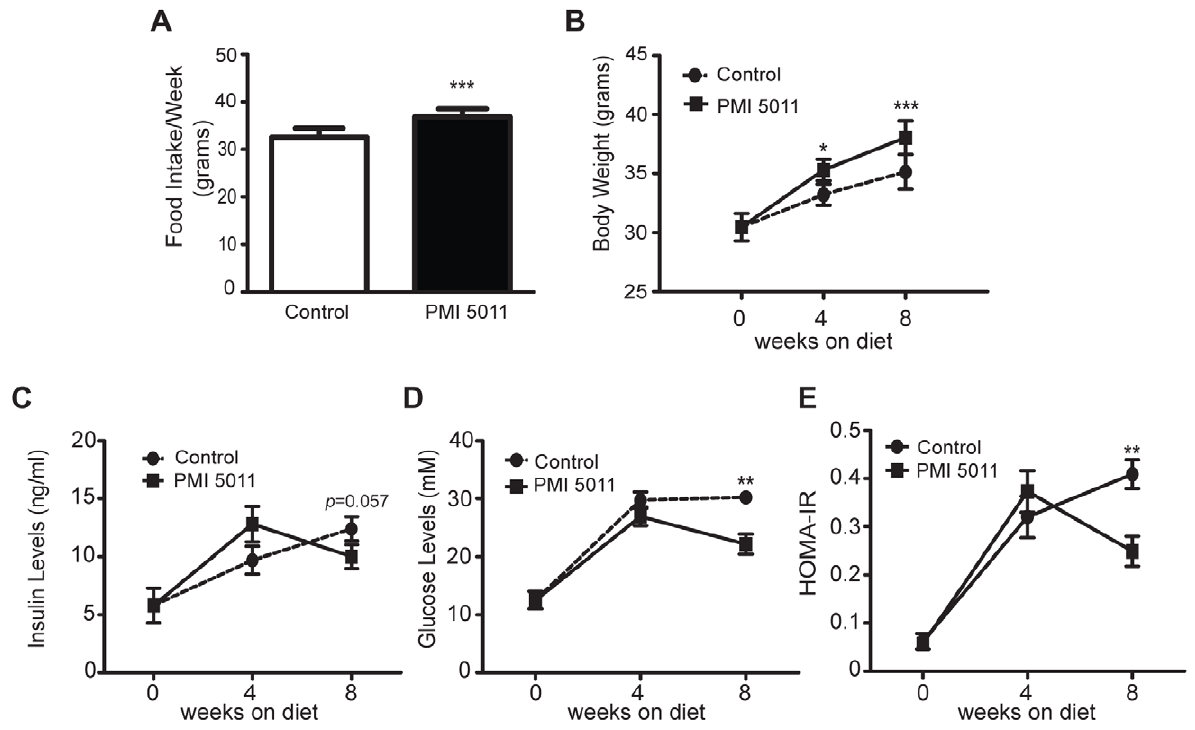
Figure 4. PMI5011 supplementation improves insulin sensitivity invivo . KK-A y mice were singly housed and maintained on a low fat diet (control, N=8) or a low fat diet containing 1% PMI5011 (w/w) (PMI5011, N=8) for two months. (A) Food intake was measured daily and (B) body weight has measured each week. (C) Plasma insulin and (D) glucose levels were determined at baseline, 4 and 8 weeks. (E) The index of homeostasis model assessment of insulin resistance [HOMA-IR; insulin (mU/L) x glucose (mM)/22.5] was calculated from fasting glucose and insulin